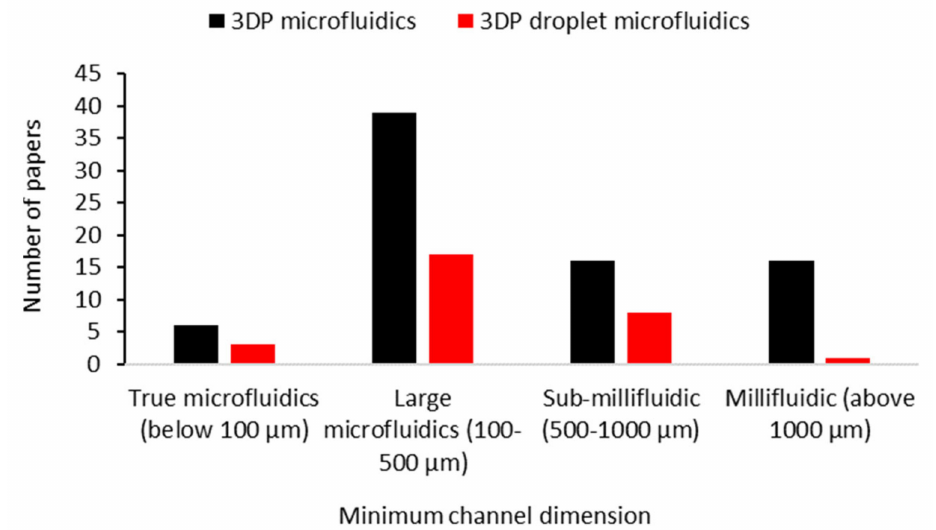
Figure 3. 3DP microfluidic chips usually have channels within the large microfluidics size domain of 100–500 µ m. Surveying the minimum channel dimensions reported in papers over the last five years revealed that most 3DP microfluidics, including droplet microfluidics, were in the category of large microfluidics with 100–500 µ m channel dimensions. As evidenced by our comparison in Figure 7, this dimension range is adequate for various biological and chemical assays. Only a few examples were in the true microfluidics group of <100 µ m channel dimensions, which indicates that while the technology is capable of producing smaller feature sizes, most biological and chemical applications do not need it. The size domains and their names were based on